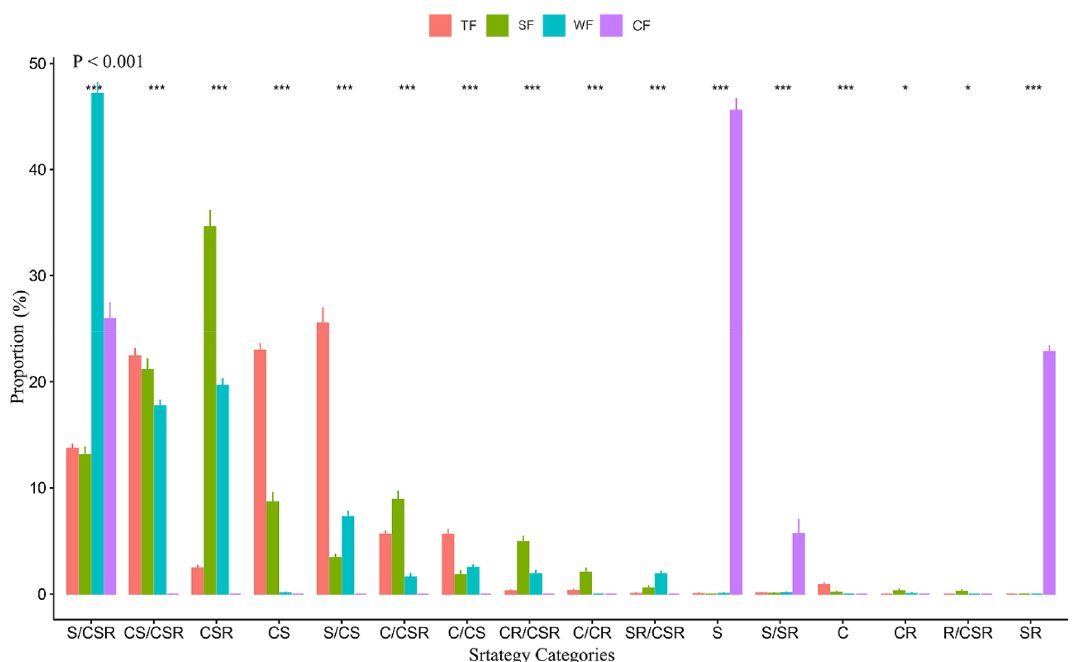
Figure 3. Variations of ecological strategy spectra in different forest vegetation types across four climatic zones in China. TF tropical rainforest, Red, SF subtropical evergreen-deciduous broadleaved mixed forest, Green, WF warm-temperate coniferous-broadleaved mixed forest, Blue, CF cold-temperate coniferous forest, Purple. The proportion (%) indicate the average of the relative number of species in each strategy category. Strategy categories indicates different ecological strategy: C indicates competitor, S indicates stress-tolerator and R indicates ruderal and more detail description refer to C-S-R classification after Hodgson 32 . Number of replicates N = 50 and means & standard errors are given. *** (P < 0.001) and * (P < 0.05) indicates significant difference in different strategy category among typical forest vegetation types. P < 0.001 in the top left indicates significant difference among ecological strategy spectra of typical forest vegetation